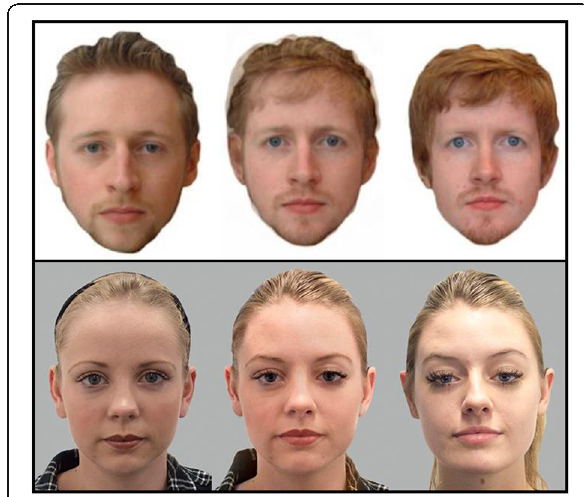
Fig. 1 Top: An example of the images used in previous work (adapted from Robertson et al., 2018). Bottom: An example of the images used in the current work (Experiment 3 1 ). The three faces depict two individuals ( left , right ) and a morph created using these images ( center ). The individuals pictured have given permission for their images to be reproduced